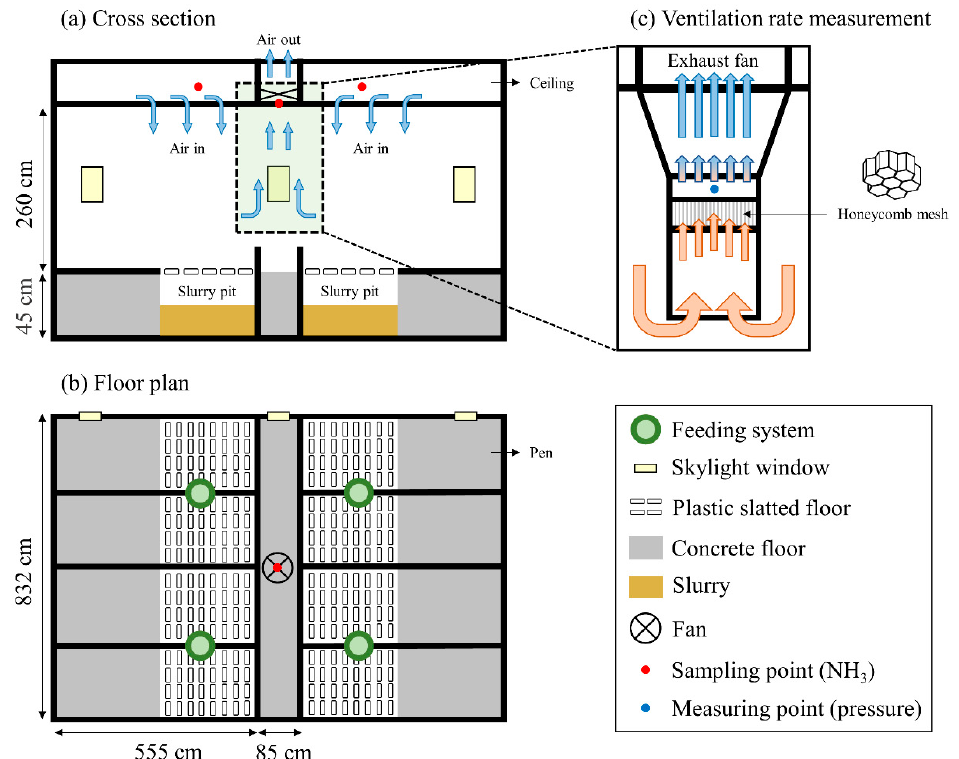
Figure 1. ( a ) Cross section, ( b ) floor plan of each room (shed), and ( c ) equipment for ventilation rate measurement used in this study.